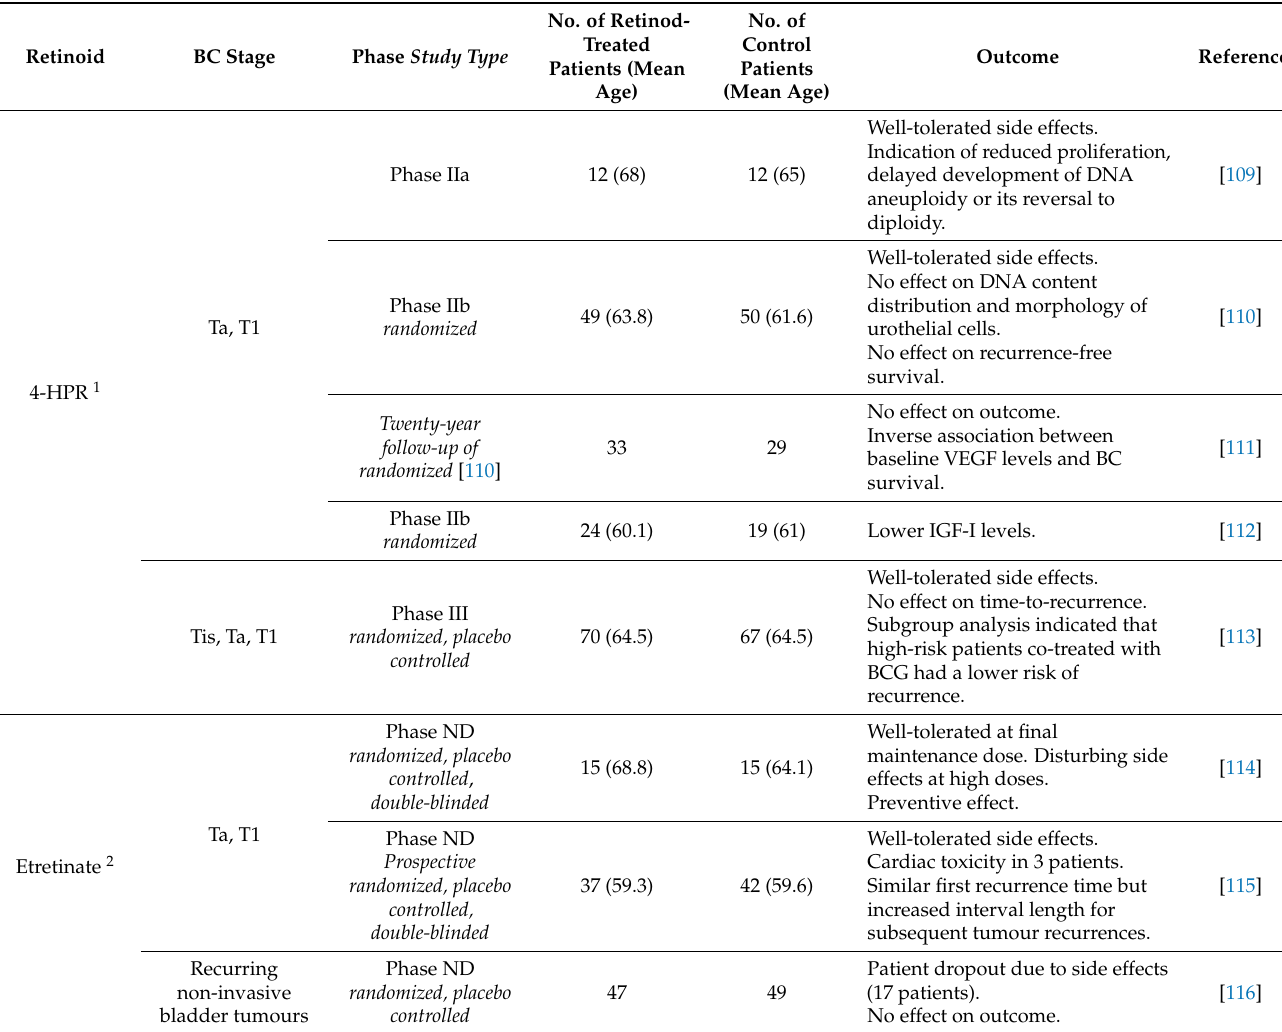
Table 3. Clinical trials investigating the chemopreventive effects of retinoids in